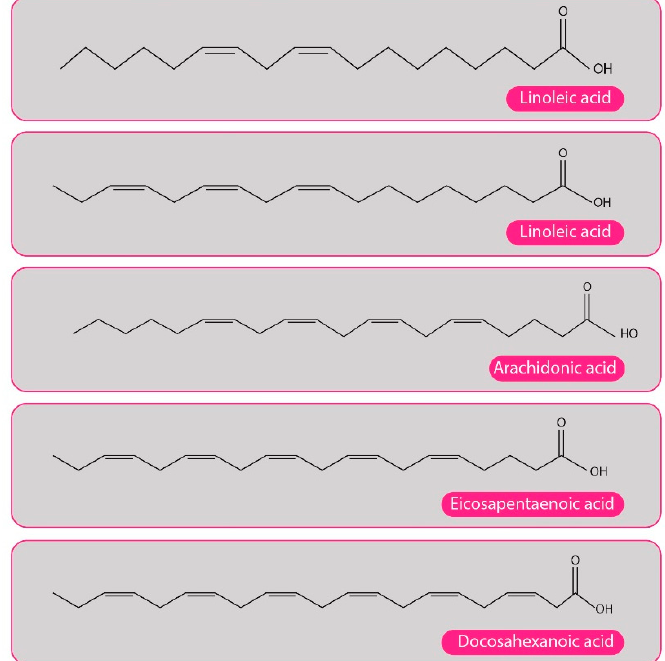
Figure 2. Structure of some fatty acids. ω 6 (linoleic acid): first double bond at the sixty-carbon molecule from the methyl end of the chain; ω 3 series (linolenic acid, C18:3; eicosapentaenoic acid, C20:5; docosahexaenoic acid, C22:6): first double bond at the third carbon molecule from the methyl end of the chain.